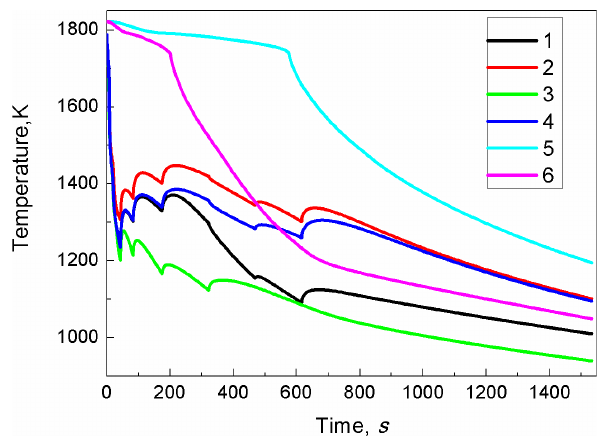
Figure 11: Temperature as a function of time at different positions.